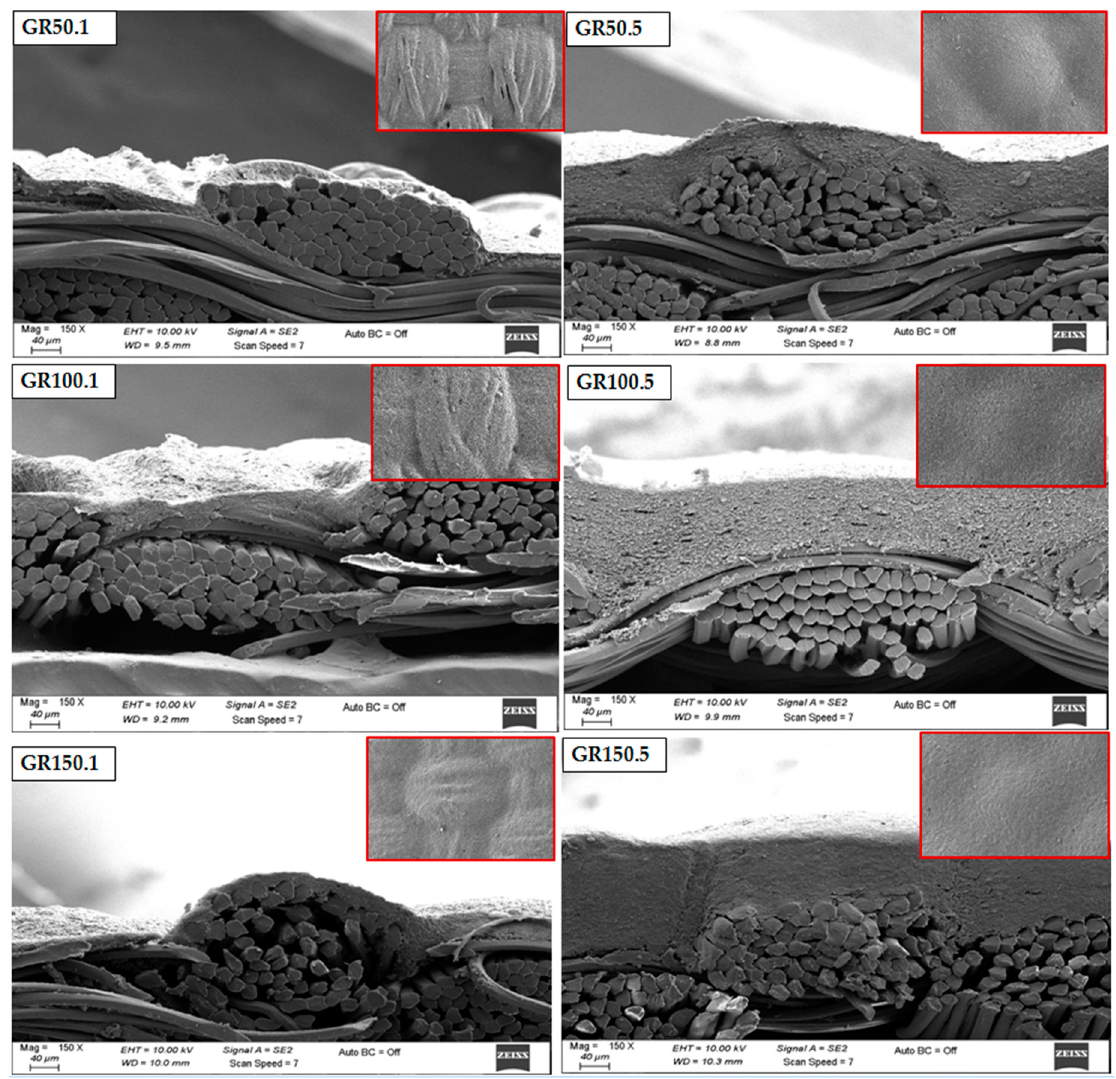
Figure 7. SEM images of graphene-coated fabrics (Mag: 150× for cross-section image).